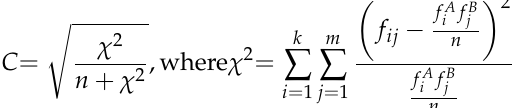
Figure 5. Spatial differentiation of quality of life in districts of Czechia. Our measurements show that the average value of men’s trust is 5.35, the average value of women’s trust is 5.25 and the overall average value of respondents is 5.30. The